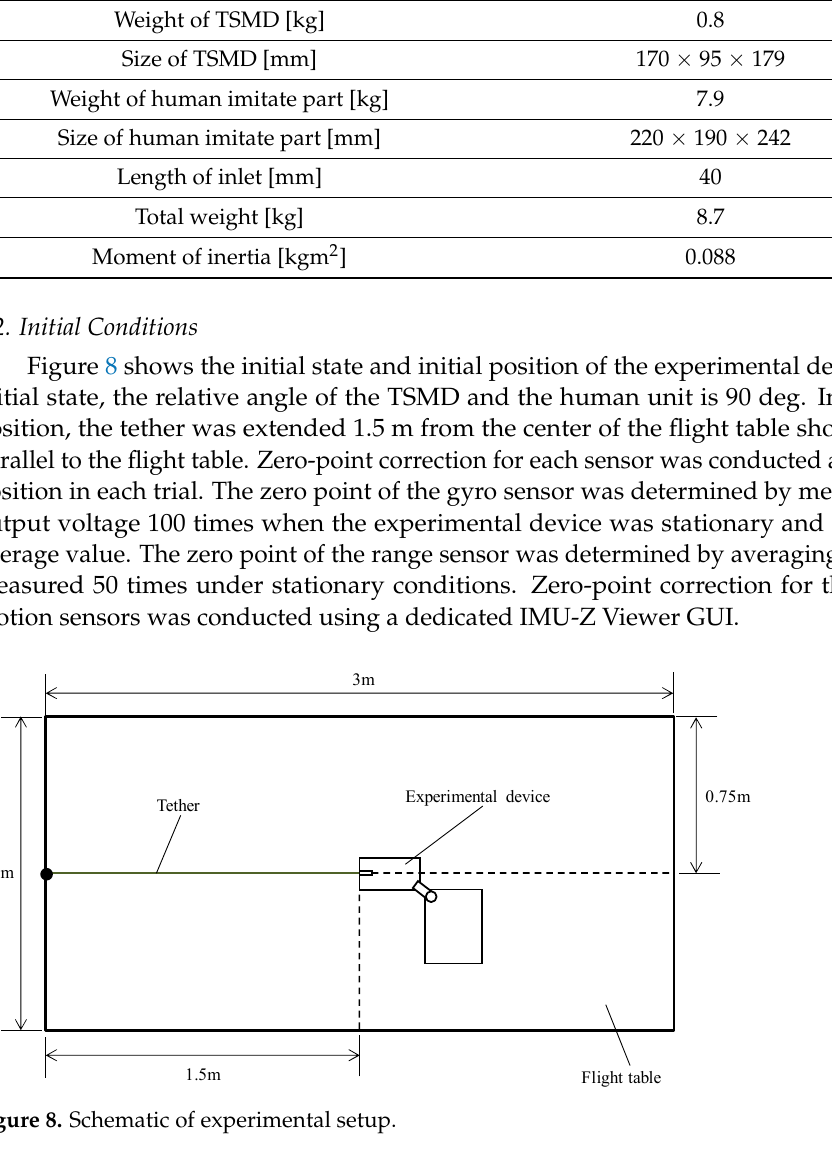
Figure 7. C ontrol system board. Table 1. Specifications of experimental device. Table 1. Specifications of experimental device.